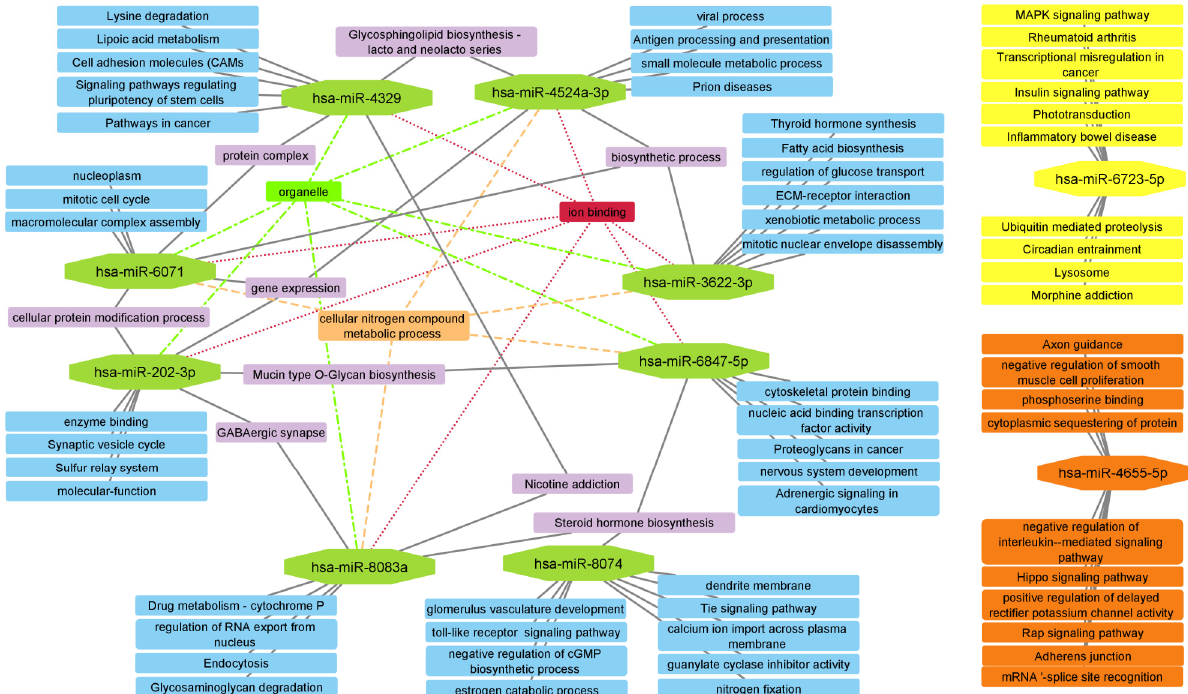
Figure 3. Functional network performed using selected downregulated miRNAs in PEXG. The network is made up of the 10 most statistically significant for each miRNA. Analysis made using DIANA-miRPath v3.0.